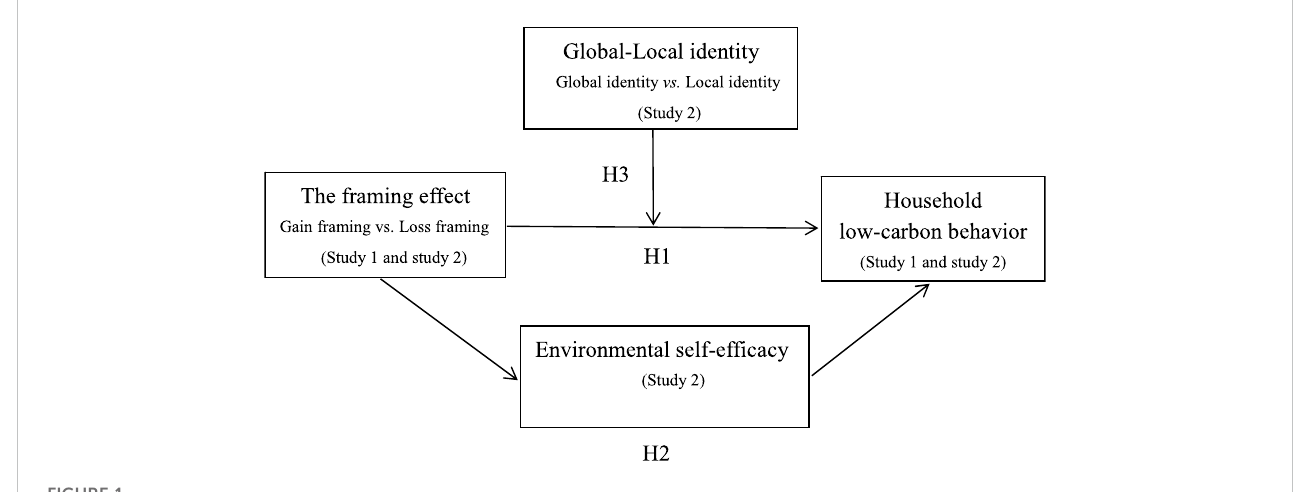
FIGURE 1 Theoretical model of the main effect, the underlying mechanism, and the moderating role of global – local